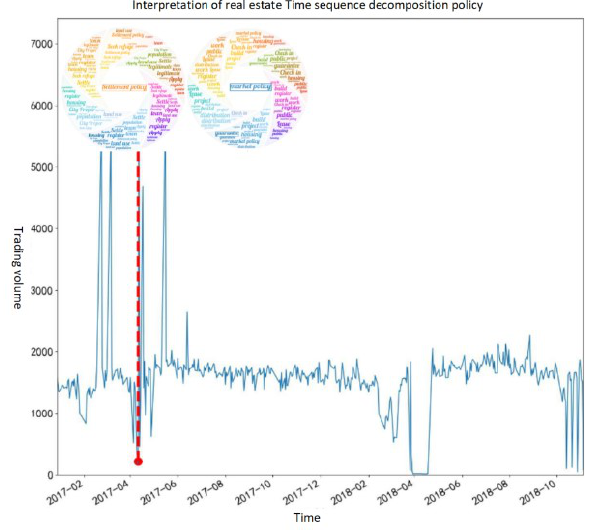
Figure 7. March 2017 Wuhan real estate transaction timing turning point policy interpretation